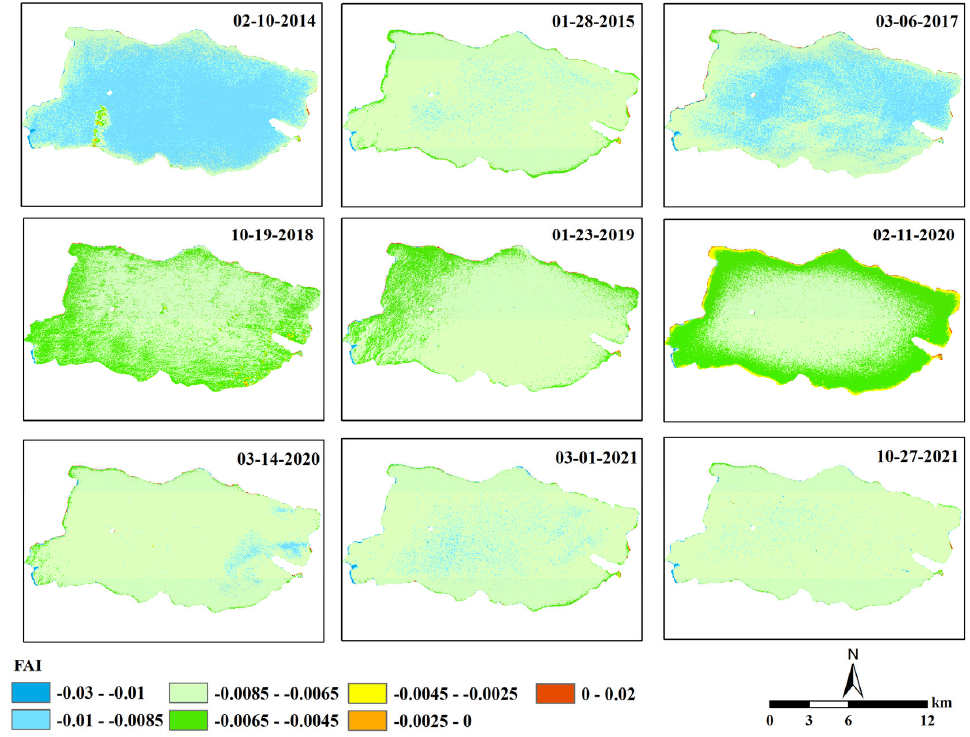
Figure 3. Spatial distribution of FAI in Lake Villarrica.